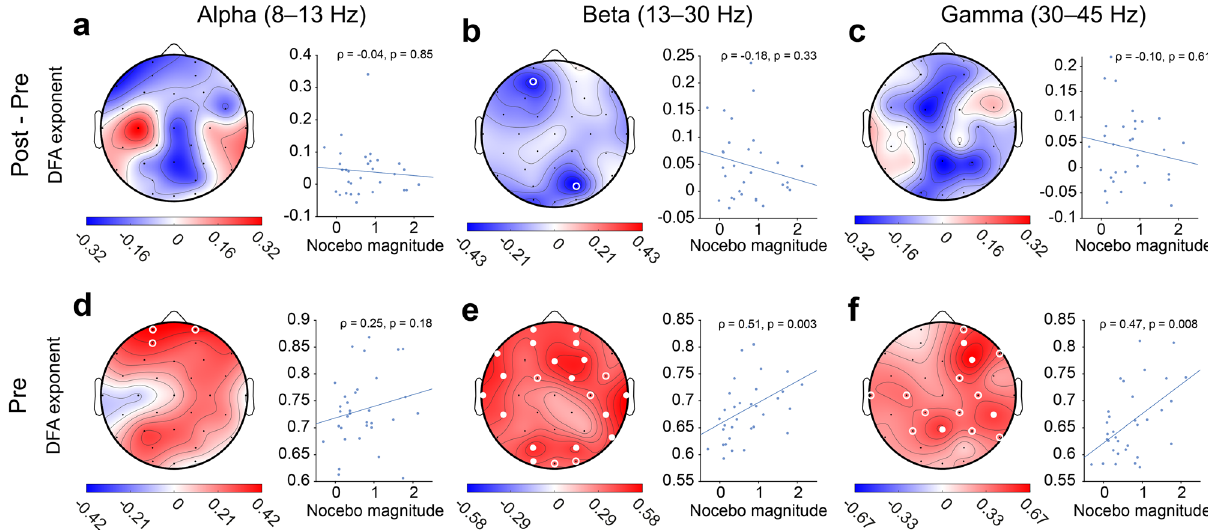
Figure 2. Complexity of neuronal oscillations at baseline predicts pain response to nocebo treatment. Spatial topographies show Spearman’s rank correlation coefficient values (rho) of magnitude of nocebo hyperalgesia and EEG measures ( n = 33). Magnitude of nocebo hyperalgesia was defined as the difference between mean pain response of all nocebo trials and all control trials during the evocation phase, per individual. Top row shows the association between magnitude of nocebo hyperalgesia and EEG parameters for the difference condition ECR POST − ECR PRE . Bottom row shows the correlation of nocebo hyperalgesia with EEG condition ECR PRE . ( a–c ) Magnitude of nocebo hyperalgesia was negatively associated with DFA within beta and gamma bands. ( d–f ) Individuals with high DFA beta and gamma at baseline (ECR PRE ) show a larger nocebo effect during evocation. Red colors indicate positive correlations, whereas blue colors indicate negative correlations. Open white circles show statistical significance at P < .05. Closed white circles indicate significance after correcting for multiple comparisons using a False Discovery Rate procedure (FDR) with q = 0.05, per topography. Scatter plots show the mean correlation coefficient based on all